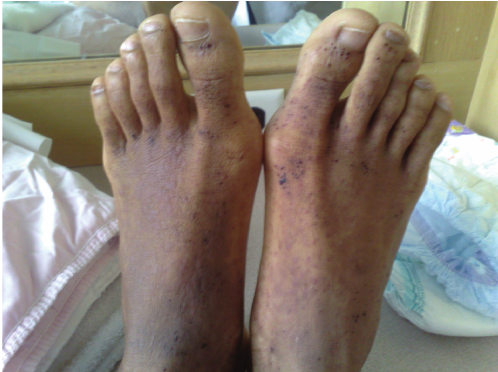
Figure 3: Endoscopic finding on EGD showing inflammation, submucosal hemorrhage, and small ulceration.